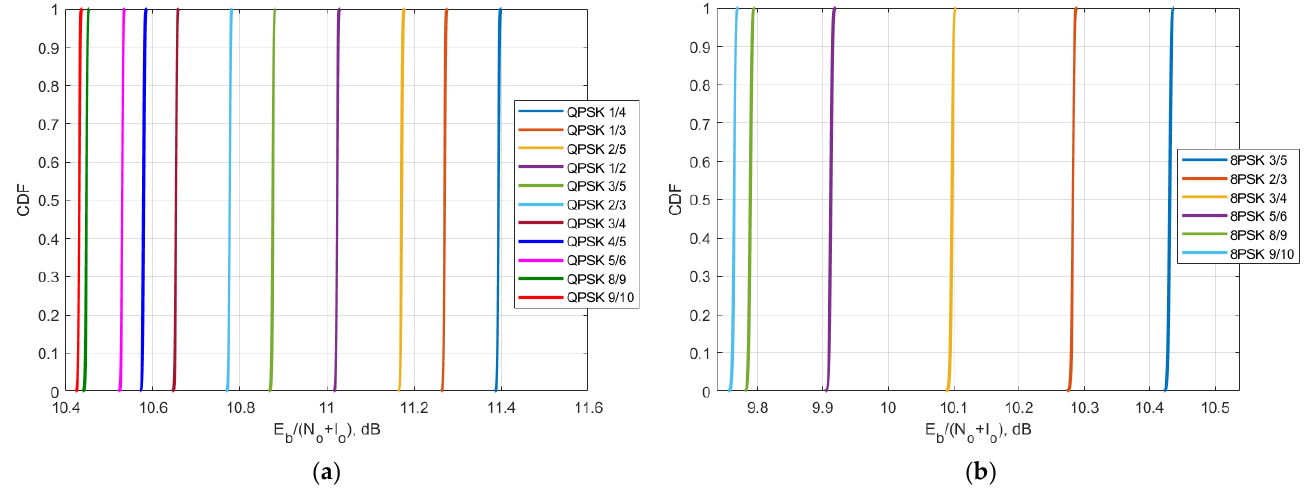
Sensors 2023 , 23 , x FOR PEER REVIEW Figure 16. The CDF of E b /N o +I o of Express 140E: ( a ) for QPSK modulation; ( b ) 8PSK modulation. Figure 16. The CDF of E b /N o + I o of Express 140E: ( a ) for QPSK modulation; ( b ) 8PSK modulation.